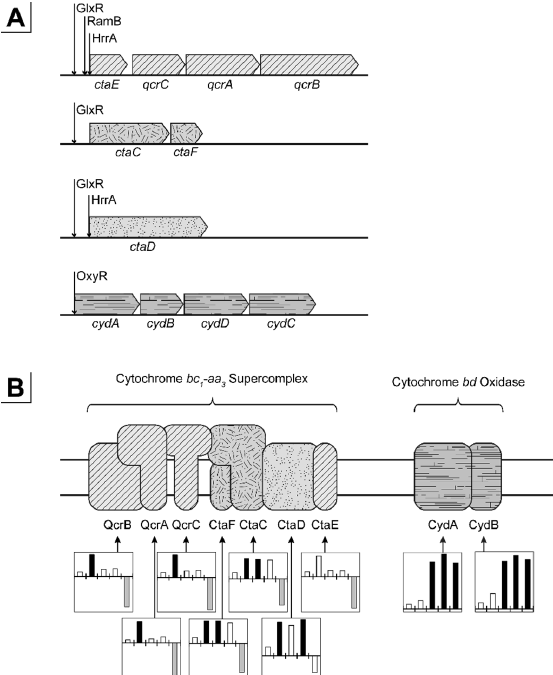
Figure 5. Transcriptional response of the cytochrome bc 1 - aa 3 and cytochrome bd oxidase to altering oxygen availabilities. ( A ) Genetic organization and operon structures. Binding of the transcriptional regulators GlxR, RamB, HcrA and OxyR is indicated. ( B ) Schematic organization of the cytochrome oxidases in the cytoplasmic membrane. Column graphs represent log 2 -fold changes of enhanced (black) and reduced (grey) expression. Open columns are values outside the significance constraints ( m -value > 1.50, < − 1.50 and a -value > 1.00). From left to right aerobiosis ( ② ), microaerobiosis ( ③ , ④ , ⑤ ), and anaerobiosis ( ⑥ ) versus the aerobic reference ( ① ; Figure 1A). Scaling of the graphs is variable. Shading links genes to proteins. Graphic A and B based on the online tool CoryneRegNet and Bott and Niebisch, respectively [86,87].